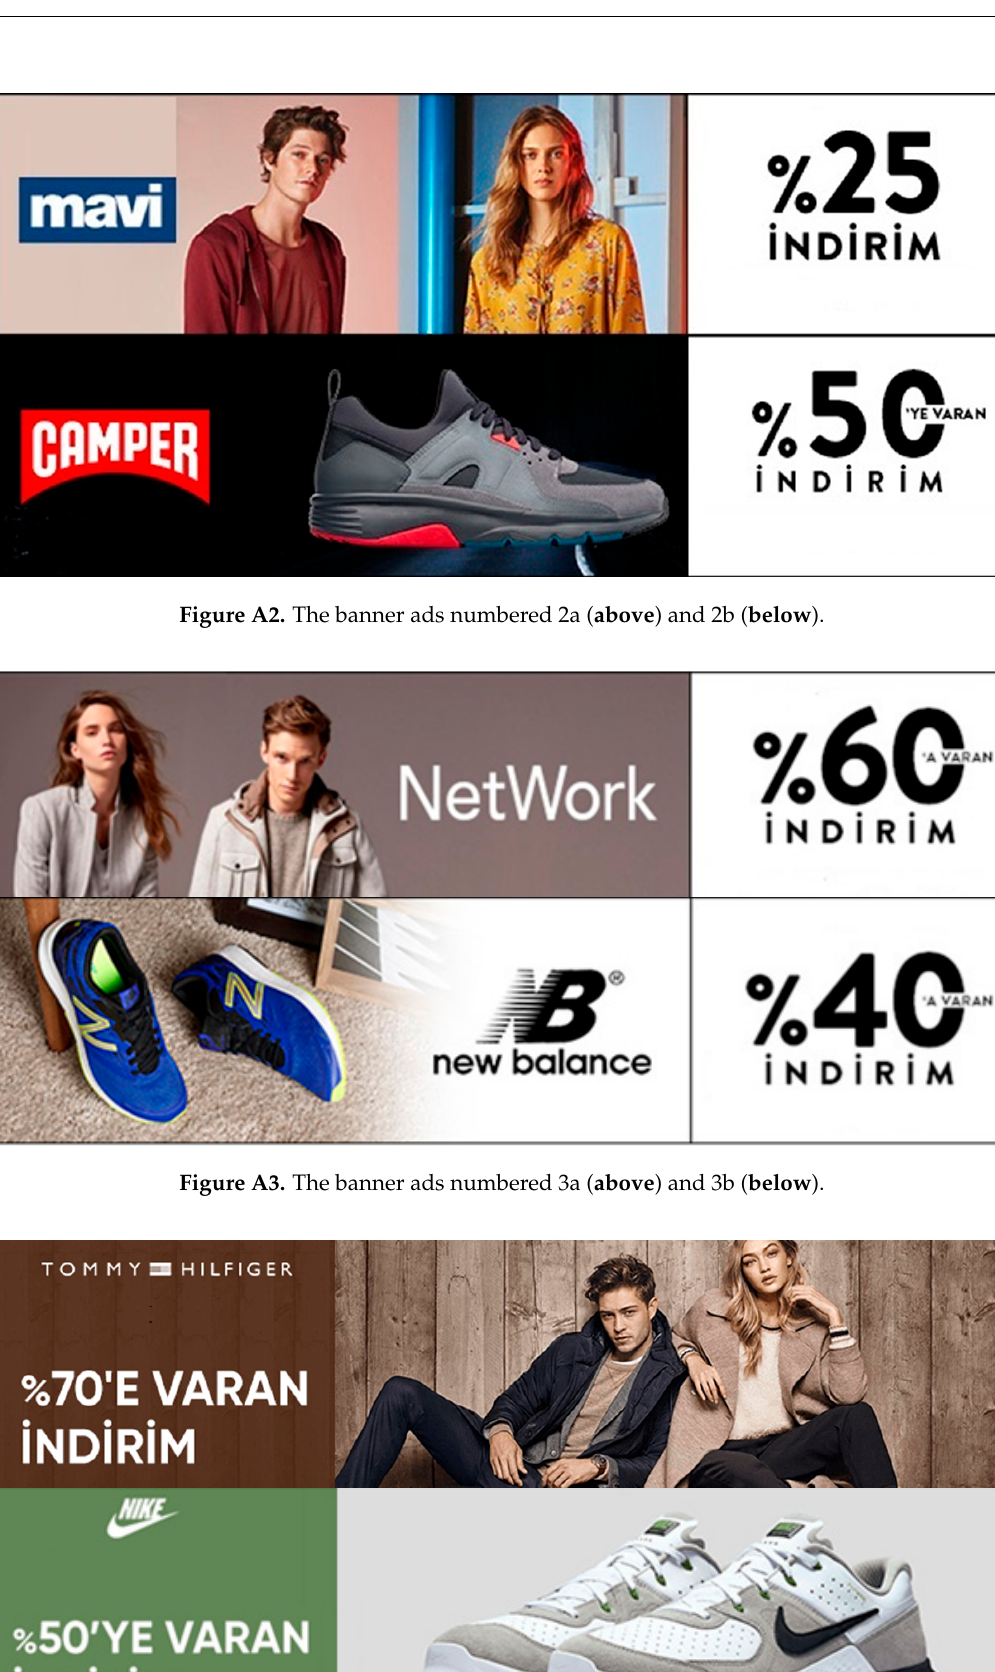
Figure A1. The banner ads numbered 1a ( above ) and 1b ( below ).